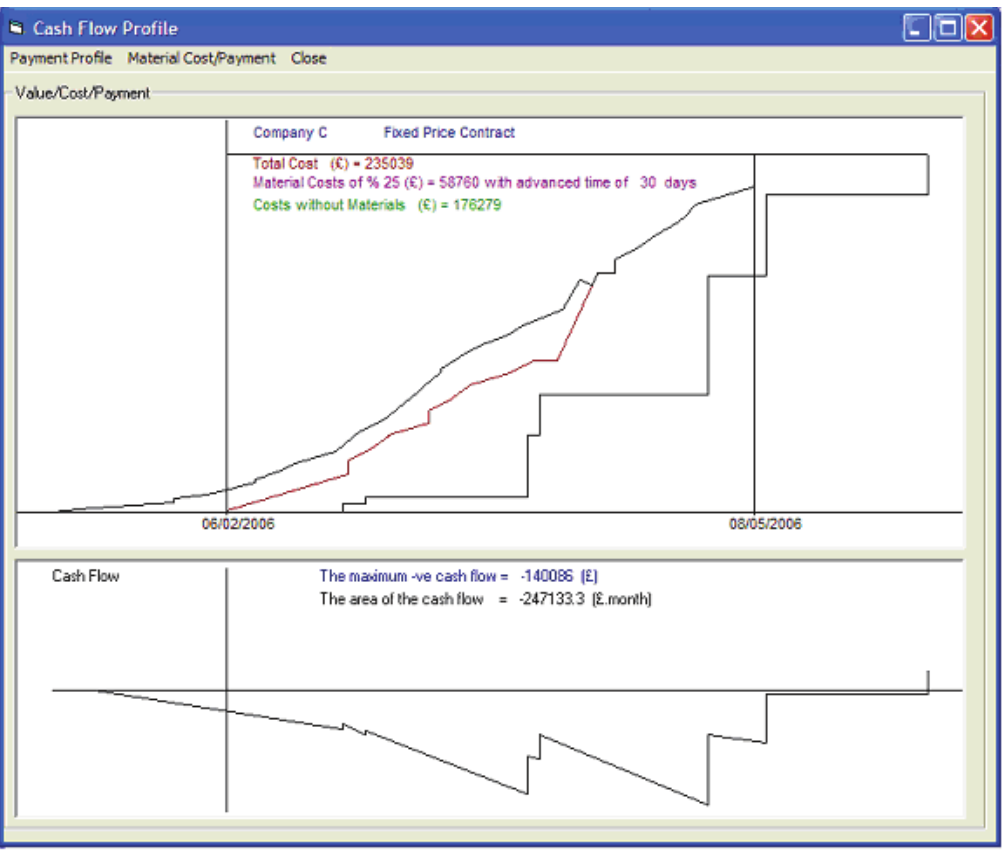
Figure 6. System output (cash flow patterns for company C considering off-site Material